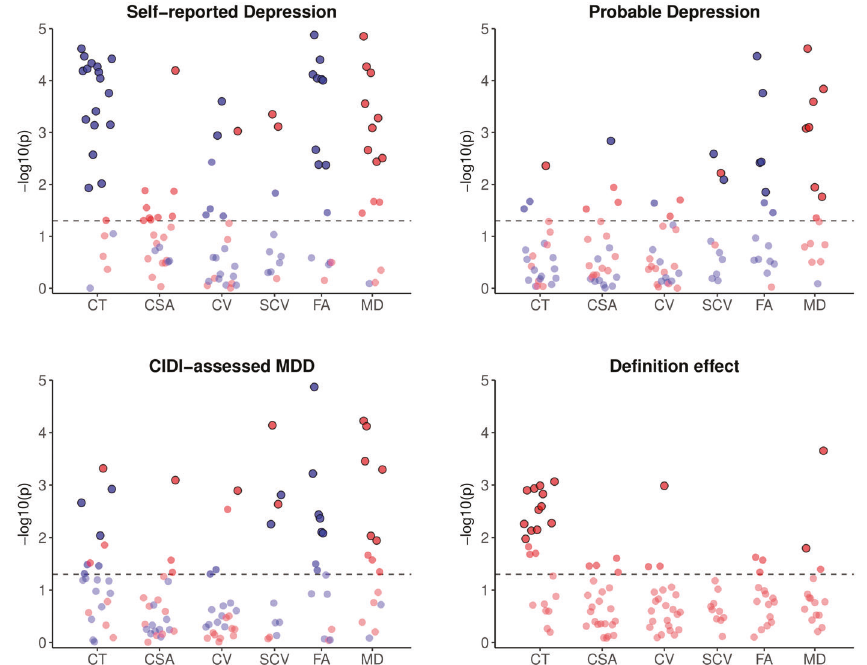
Fig. 2 Signi fi cance of associations between lifetime depression phenotypes and individual cortical, subcortical and white matter metrics, and effects of phenotype de fi nition on these associations. Notes . CIDI = Composite International Diagnostic Interview (short form); MDD = Major Depressive Disorder; CT = cortical thickness; CSA = cortical surface area; CV = cortical volume; SCV = subcortical volume; FA = fractional anisotropy; MD = mean diffusivity. Phenotype effects for each metric represent the difference, assessed using z-tests, between the two most disparate of the β coef fi cients for the three phenotypes ’ associations with that metric. Red and blue points represent positive and negative associations, respectively. Horizontal dashed lines represent p = 0.05; outlined points represent associations that remained signi fi cant following FDR correction. β coef fi cients for all plotted results are reported in Supplementary Materials (Tables S3 –